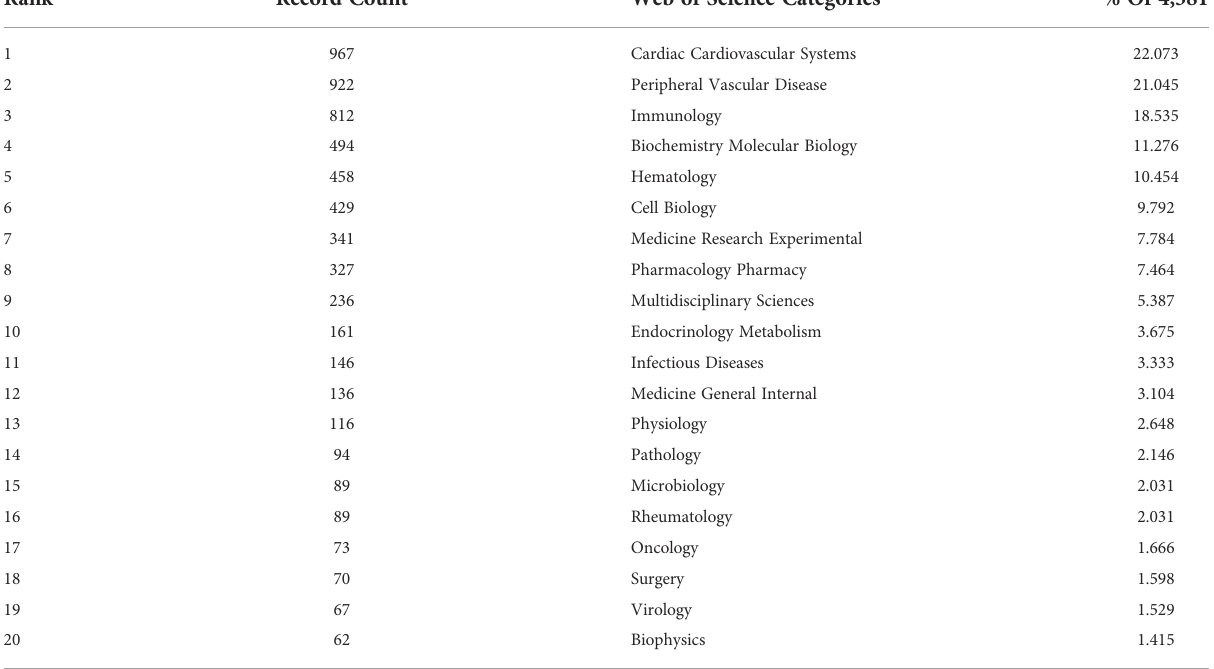
TABLE 5 Top 20 categories in T cell and